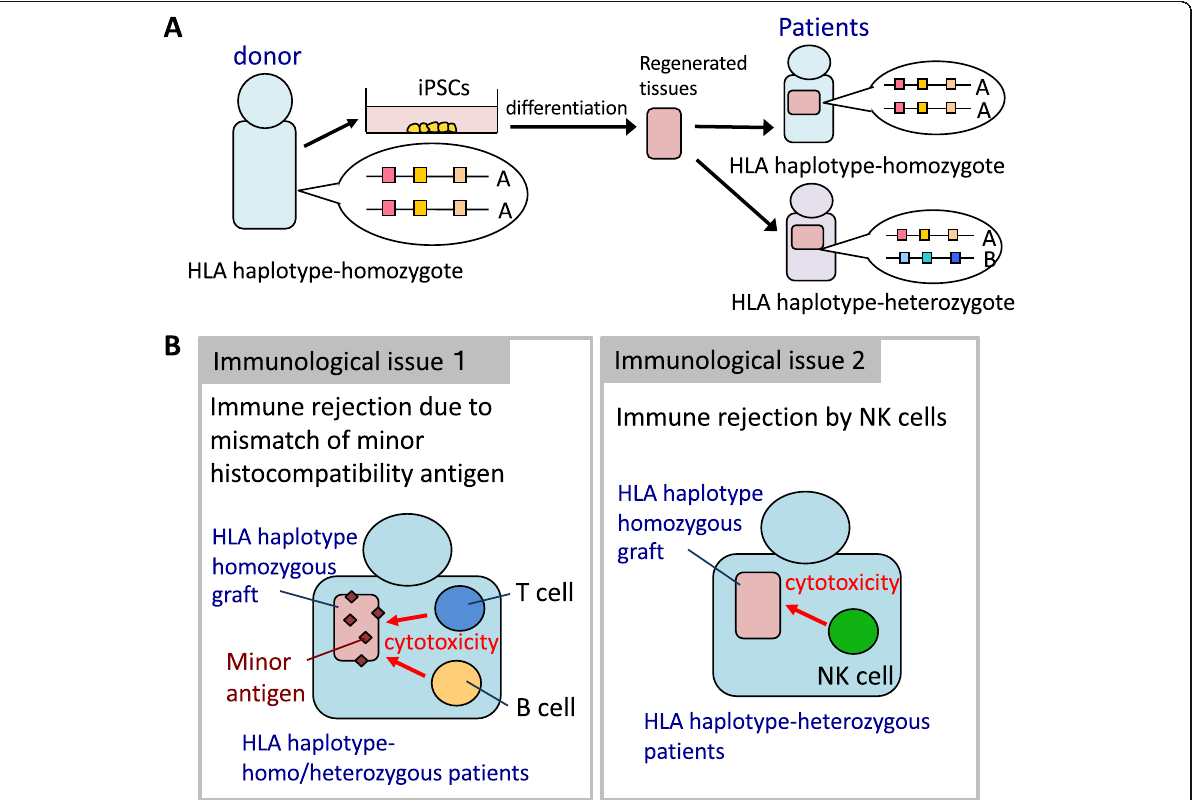
Fig. 1. The concept of “ iPS Cell Stock Project ” and remaining immunological issues. a The concept of the “ iPS Cell Stock Project ” . iPSCs established from monocytes of HLA-homo healthy volunteers can be applied not only to the recipient who has the same HLA in both alleles, but also the one who has it in one allele. No T cell-mediated immune response in the recipient takes place against HLA-homo regenerated graft because the graft has the same HLA as the recipient. b Immunological issues in homo-to-hetero transplantation. Issue 1: the mismatch of minor histocompatibility antigens. Minor histocompatibility antigens expressed in grafts do not match to the recipients except in the case of monozygotic twins. Immune rejection may take place when immune cells recognize these antigens in either HLA-homo or HLA-hetero recipients. Issue 2: NK cell-mediated immune reaction. NK cells in the HLA-hetero recipient may recognize HLA-homo regenerated graft and